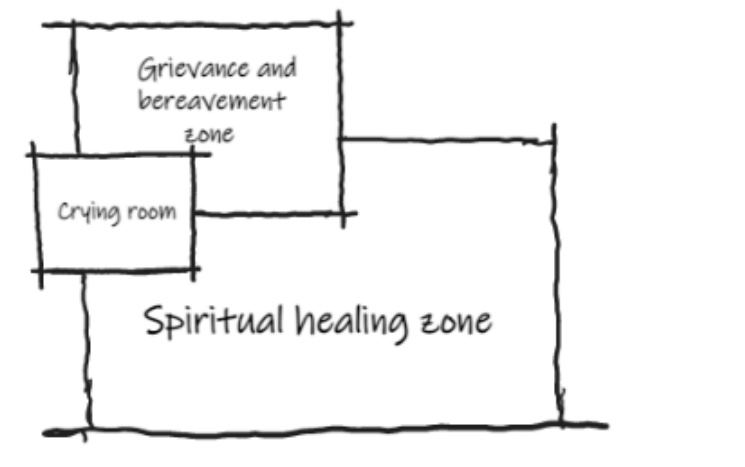
Figure 8: Grievance areas should be secluded and kept at the back of the spiritual